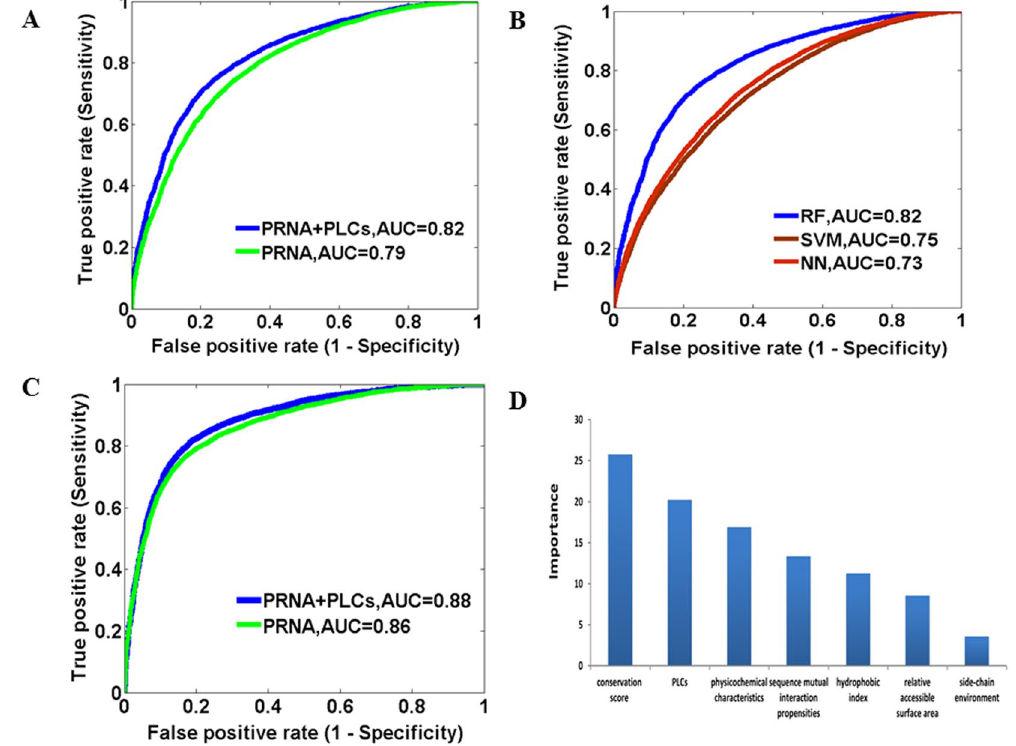
Figure 4. The performance of RNA binding site prediction. ( A ) Comparison of ROC curves for binding site prediction using different features on our constructed database. ( B ) Comparison of ROC curves for binding site prediction using different classifiers. ( C ) Comparison of ROC curves for binding site prediction on an independent dataset. ( D ) The importance and individual contribution ratio of each feature